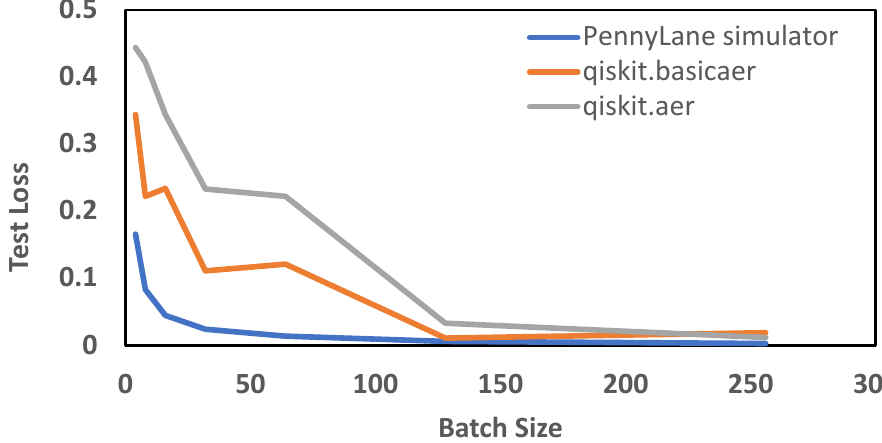
Figure 12. Test loss with respect to batch size for the classical–quantum neural network.